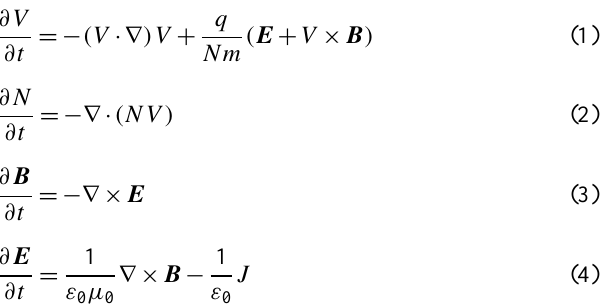
with the same frequency at 12:23:30 UT, and with the cy- clotron frequency f c = 69